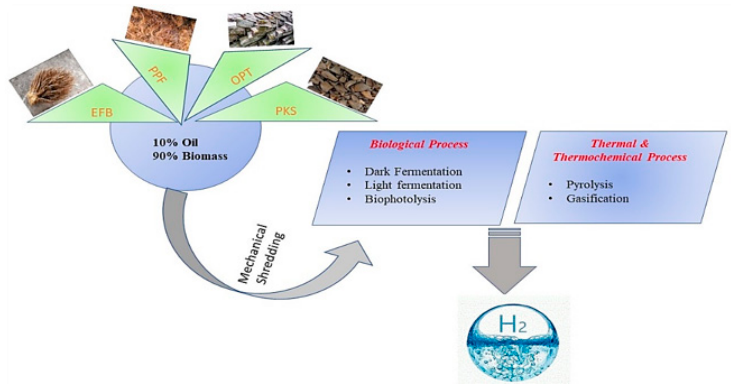
Figure 4. Biohydrogen production from palm oil mill biomass. PPF: palm pressed fiber.